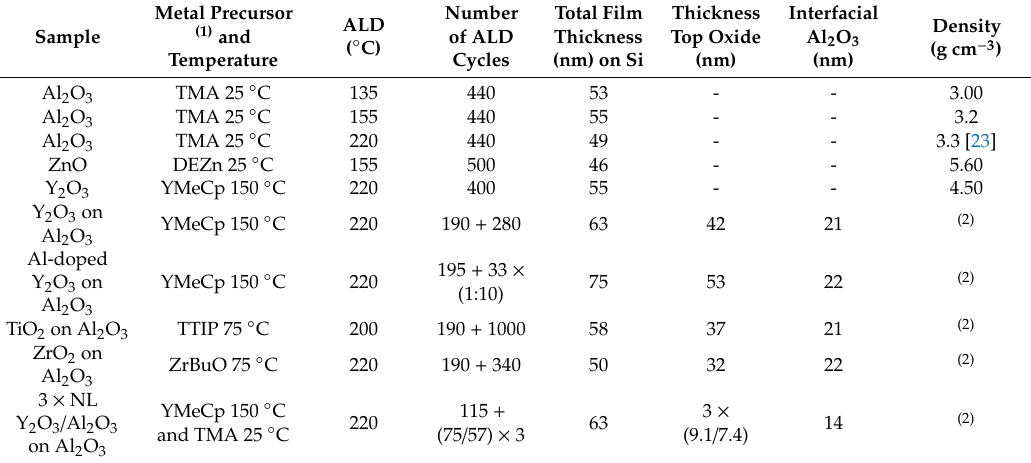
Table 1. Atomic layer deposition (ALD) metal oxide film materials and metal precursors used together with H 2 O to deposit the films. Thickness and density of the films grown on Si were obtained by X-ray